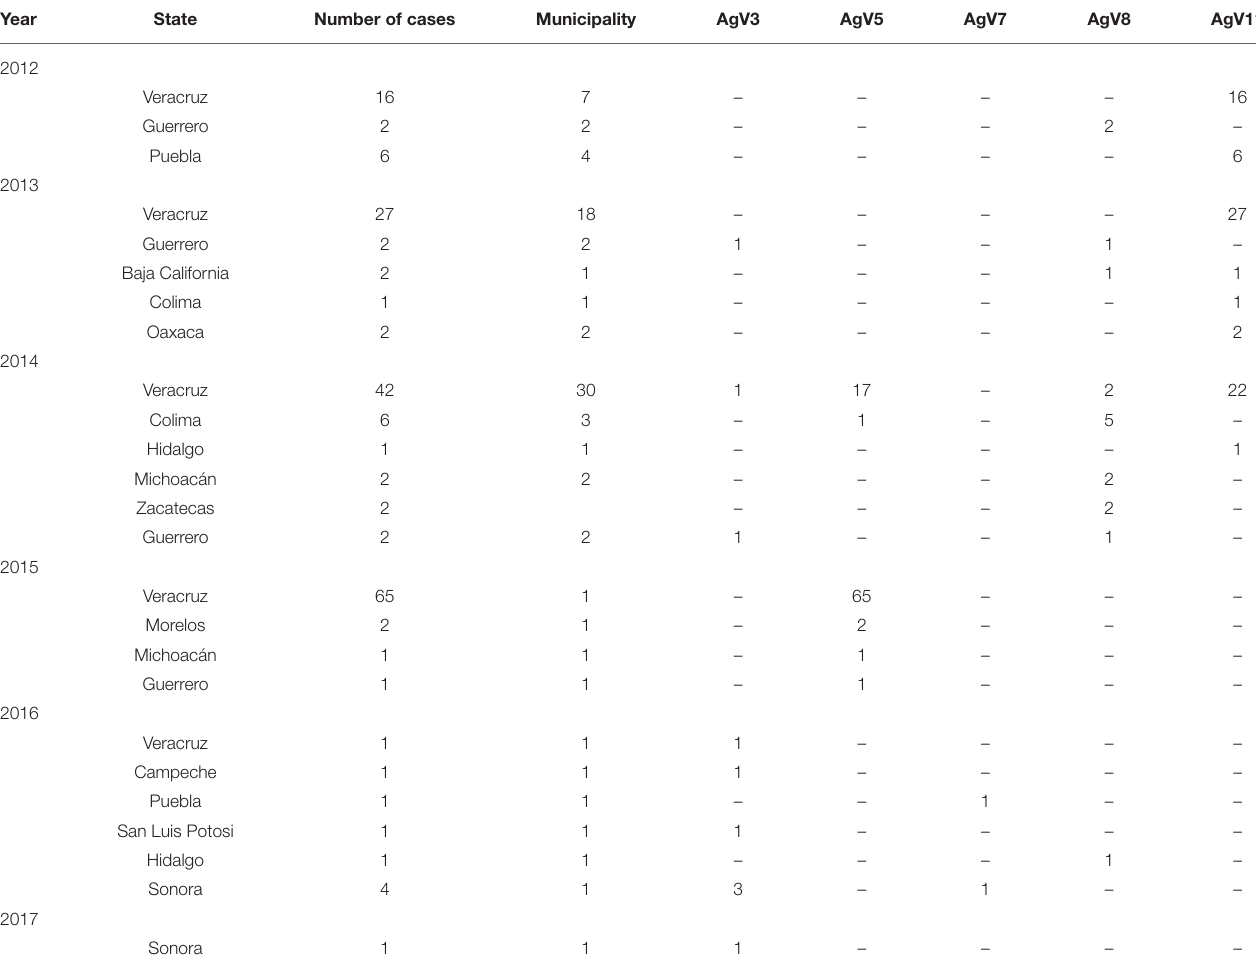
TABLE 3 | Number of cases of rabies in different animal species per year, state, municipaliy, and type of antigenic variant in